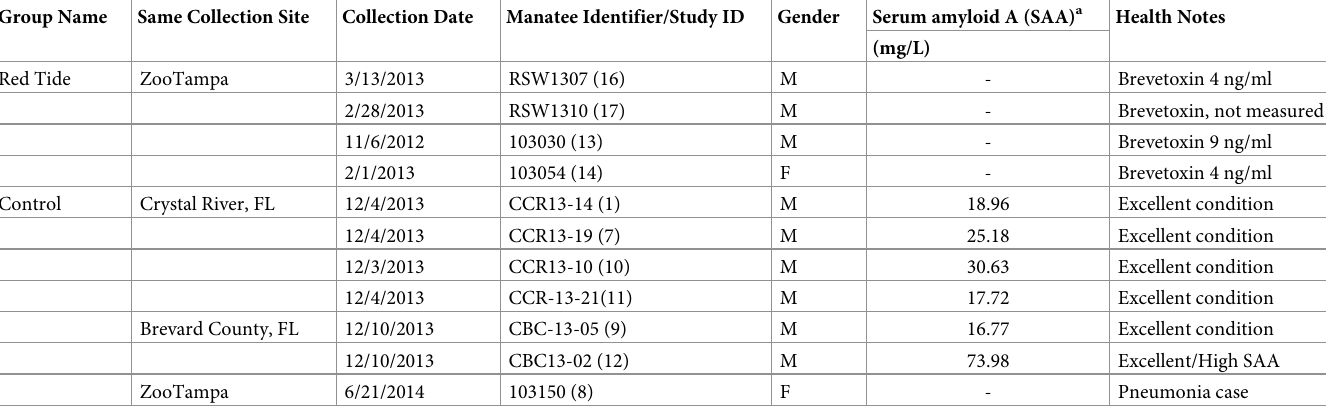
Table 1. Identification of Florida manatees used in the RNA-Seq